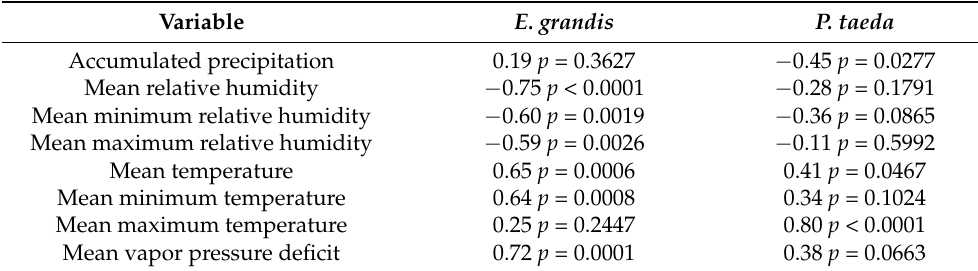
Table 3. Spearman’s correlation coefficients between the dry weight of seasonally fallen litter and seasonal climatic variables ( n = 24). Variable E. grandis P. taeda Accumulated precipitation 0.19 p = 0.3627 − 0.45 p = 0.0277 Mean relative humidity − 0.75 p < 0.0001 − 0.28 p = 0.1791 Mean minimum relative humidity − 0.60 p = 0.0019 − 0.36 p = 0.0865 Mean maximum relative humidity − 0.59 p = 0.0026 − 0.11 p = 0.5992 Mean temperature 0.65 p = 0.0006 0.41 p = 0.0467 Mean minimum temperature 0.64 p = 0.0008 Mean maximum